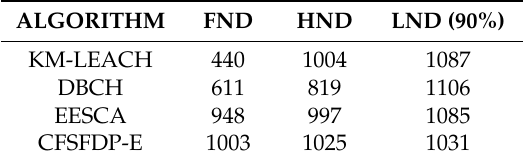
Table 9. Network lifetime Comparison of KM-LEACH, DBCH, EESCA and CFSFDP-E. ALGORITHM FND HND LND (90%) KM-LEACH